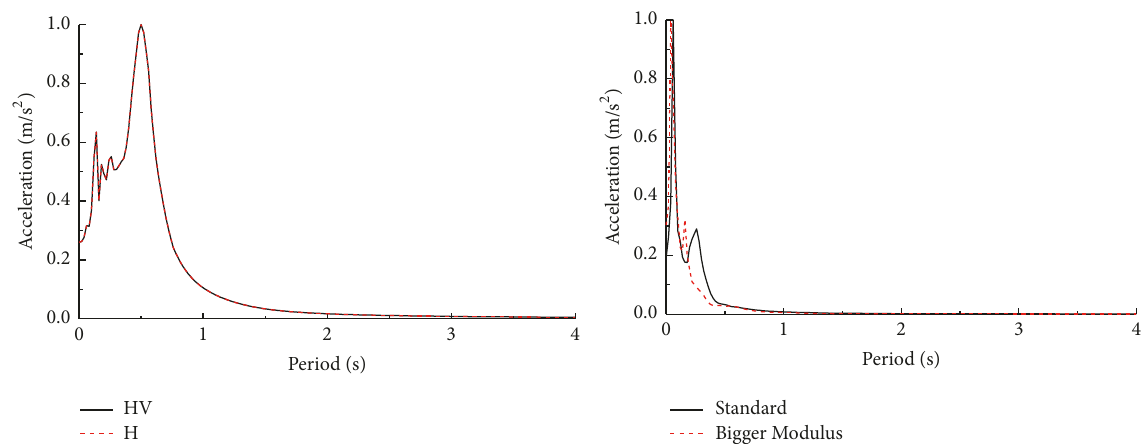
Figure 17: Normalized horizontal and vertical acceleration spectrum curves at node 103 under EL wave for HV and H case.